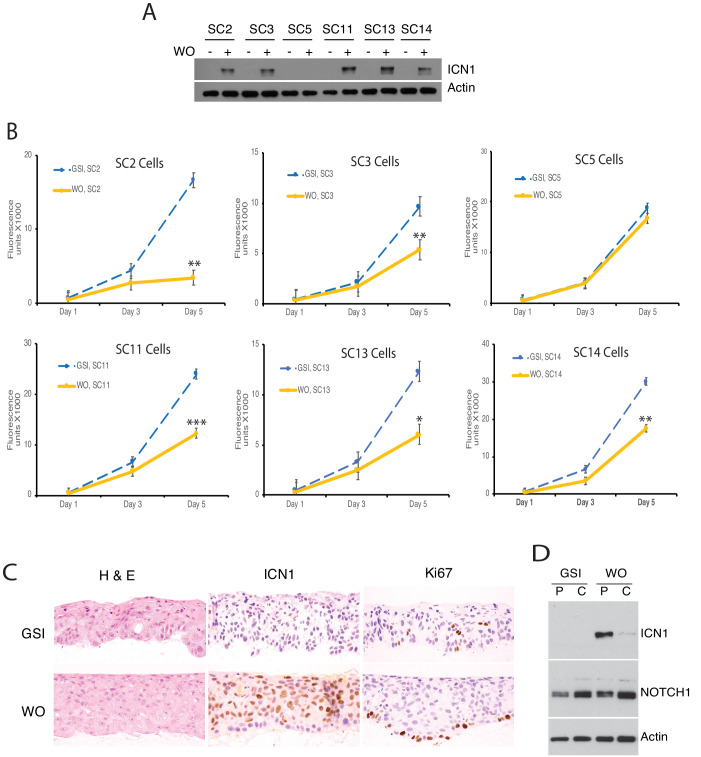
Characterization of clones derived from single IC8 cells transduced with ΔEGF-L1596H.(A) Western blot showing ICN1 levels 4 hr post-GSI washout in IC8-ΔEGF-L1596H clones. (B) Effects of Notch activation on growth of IC8-ΔEGF-L1596H clones. Cell numbers at various times post-GSI washout (WO) or sham GSI-washout (GSI) were assessed with Cell Titer-Blue in biological replicates prepared in quadruplicate. Error bars represent standard deviations. Timepoints with significantly different cell growth between Notch-on cells (DMSO, empty vector) and Notch-off cells (GSI) are denoted with * (p<0.05), ** (p<0.005), or *** (p<0.0005) (two-tailed student t test). (C) Formation of a 3D epidermal layer by SC2 cells in skin raft culture in the presence of GSI and following GSI washout. Raft sections were stained with H and E (hematoxylin and eosin) or with antibodies specific for ICN1 (activated intracellular NOTCH1) or Ki67. (D) Effect of matrix on accumulation of ICN1 following GSI washout. SC2 cells were plated on plastic (P) or collagen (C) in the present of GSI and then subjected to sham (GSI) or true GSI washout (WO). Cell extracts were prepared 24 hr after washout and analyzed by western blot.